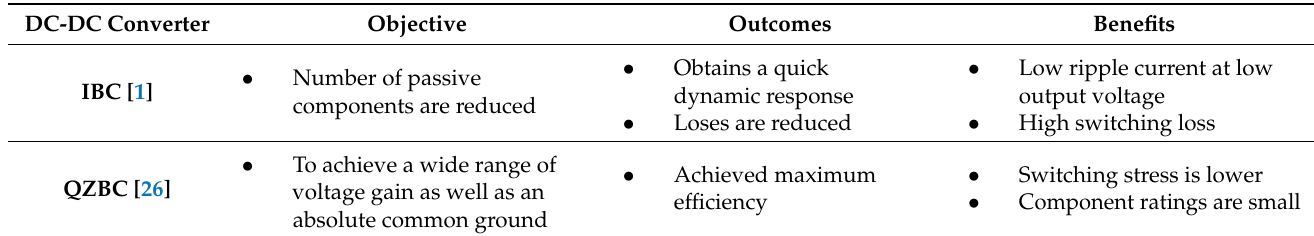
Table 2. Comparison of objective, outcome and benefits of different converters with